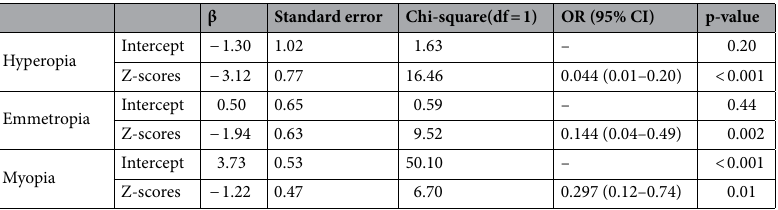
Table 4. Multinomial logistic regression model used to predict high myopia at third visit given Z-score from first visit. The reference category is high